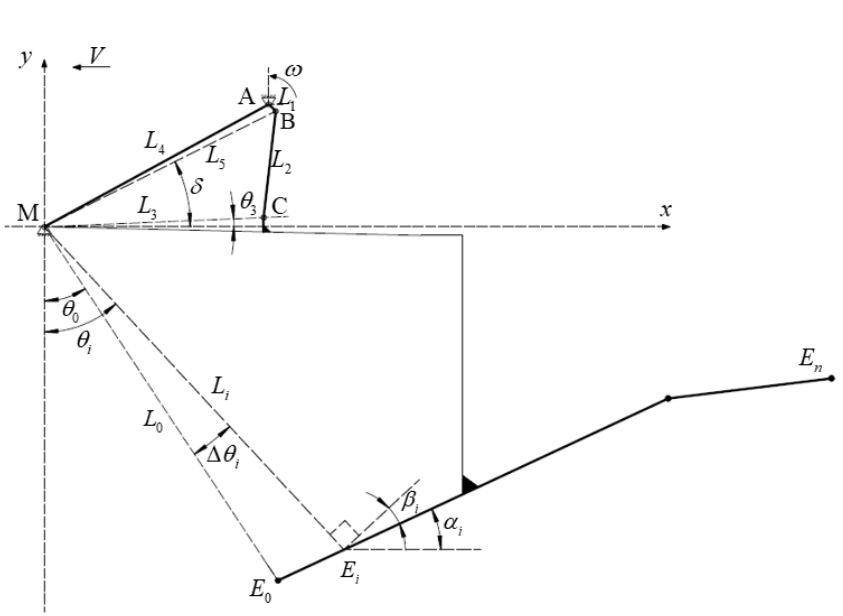
Figure 2. Motion analysis diagram of oscillating shovel-rod. Angle θ 3 is calculated by Equation (2).